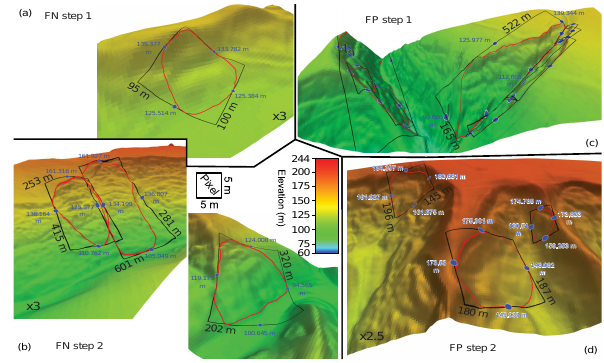
Figure 6. Three-dimensional views of different types of long vs. wide landslide classifications: (a) false positive cases (long land- slides classified as wide landslides) in step 1, (b) false positives in step 2, (c) false negative cases (wide landslides classified as long landslides) in step 1 and (d) false negative cases in step 2.